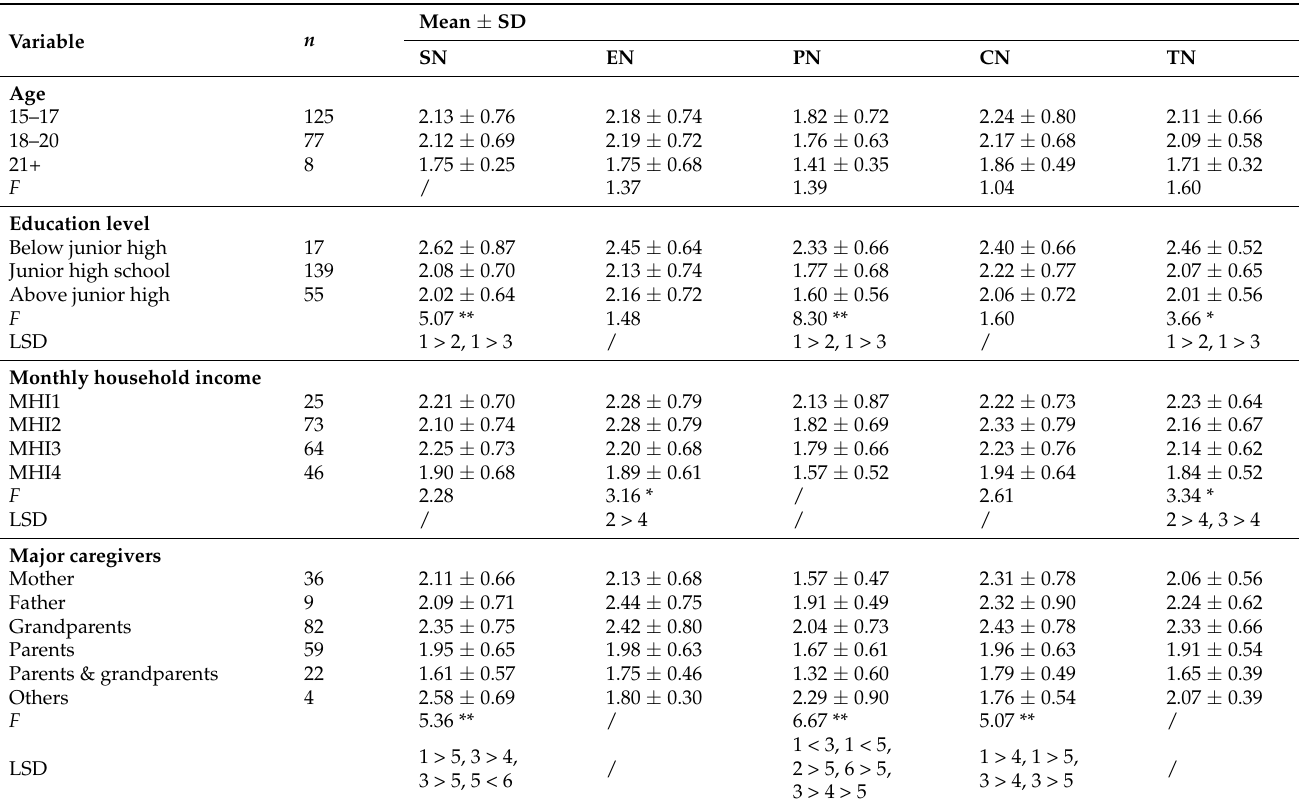
Table 7. One-way ANOVA results of child neglect among juvenile